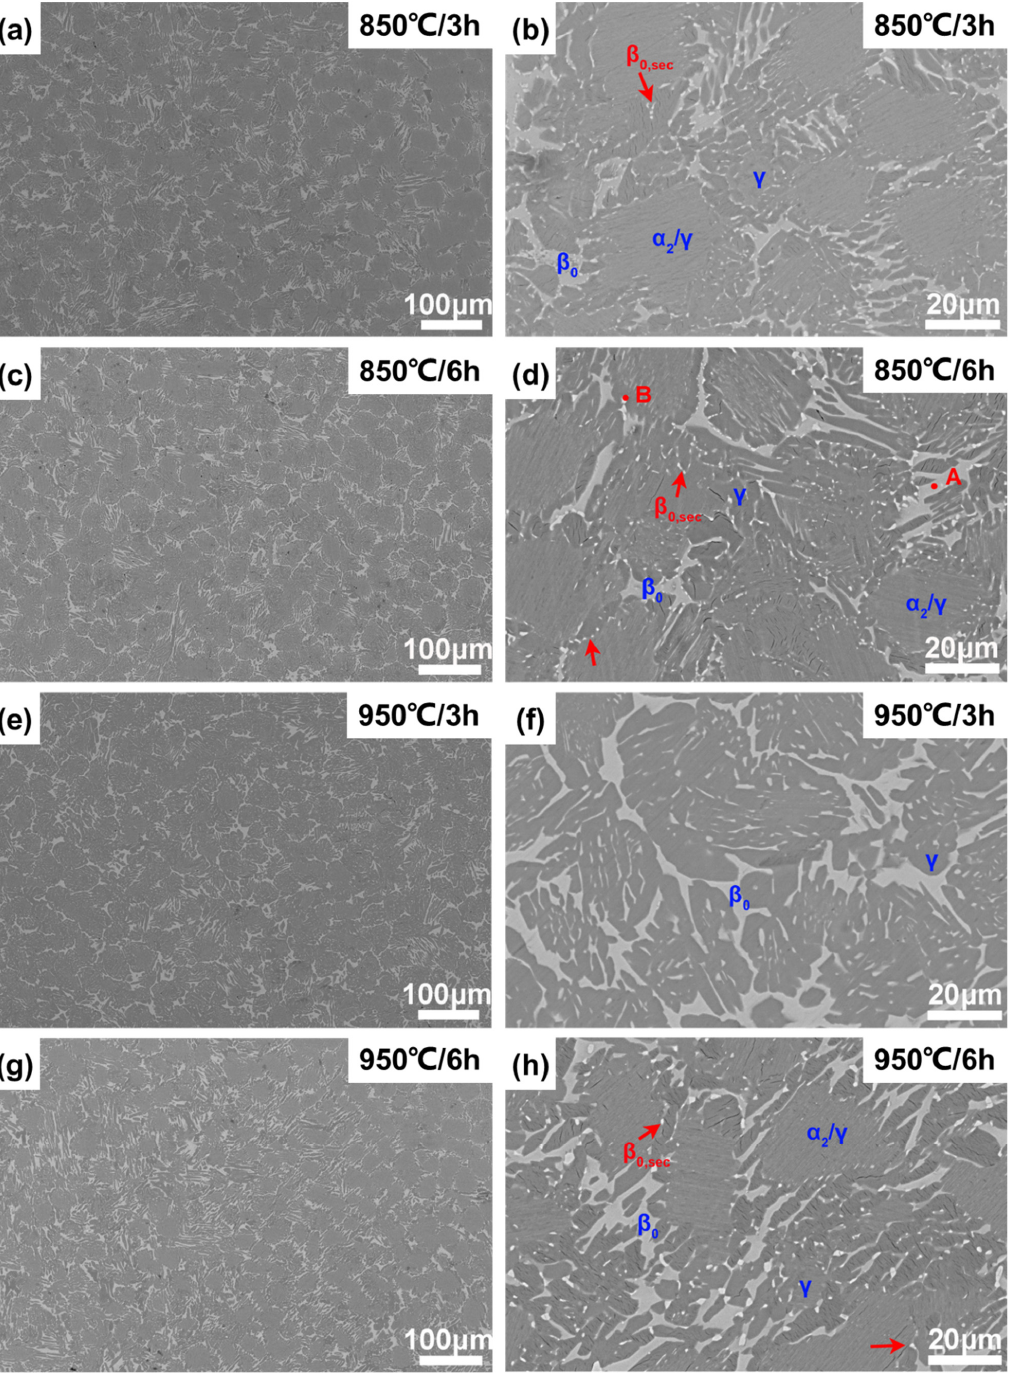
Figure 6. The SEM-BSE photos of TiAlMn alloy after different aging treatments: ( a , b ) HT1, ( c , d ) HT2, ( e , f ) HT3, ( g , h ) HT4.